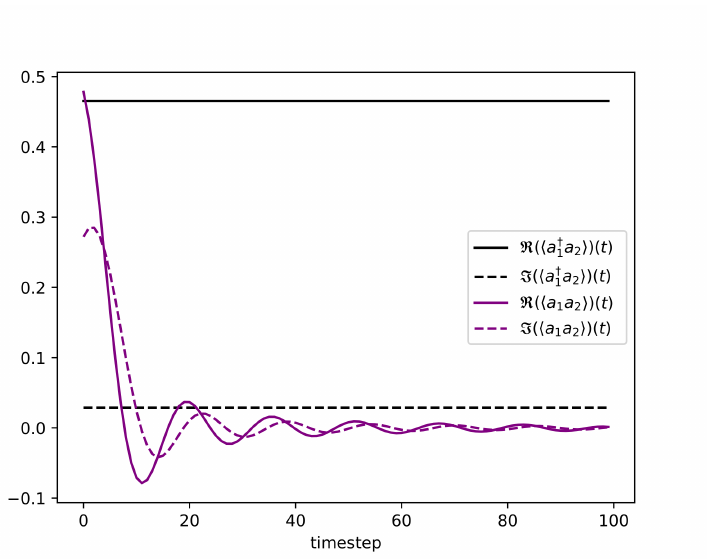
Figure 7: The time evolution induced by the Hopping Hamiltonian of the real and 〉 and 〈 a 〉 of the translational invariant state specified in a a imaginary part of 〈 a † 2 1 2 1 the code. The expectation values evolve as predicted by equations